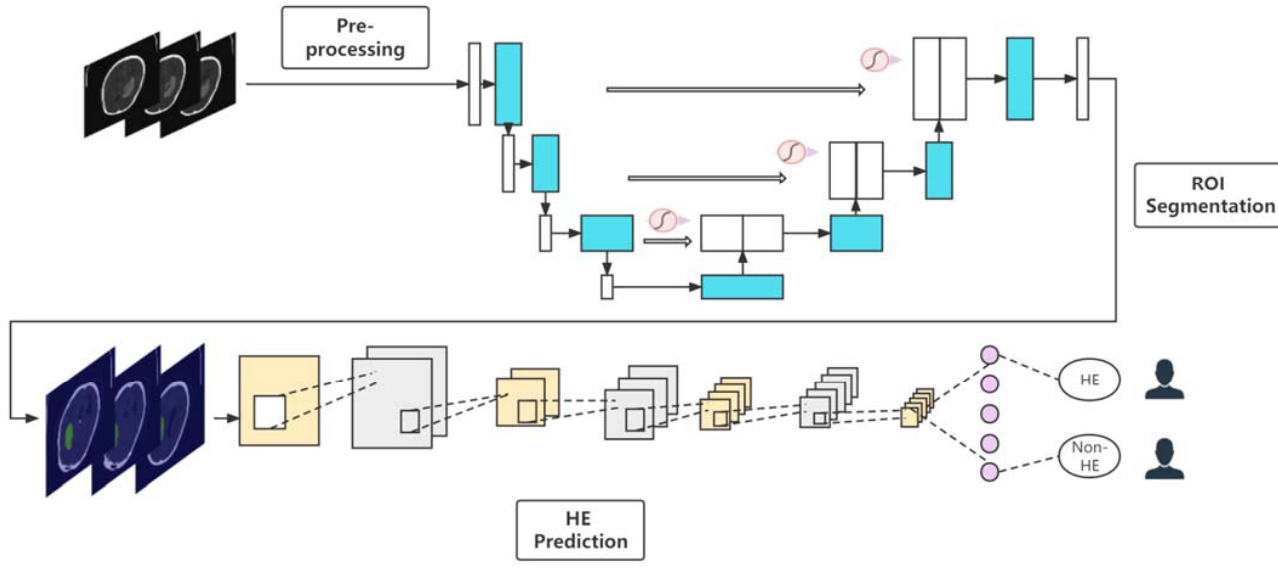
Figure 1. The workflow of this end ‐ to ‐ end deep learning method.